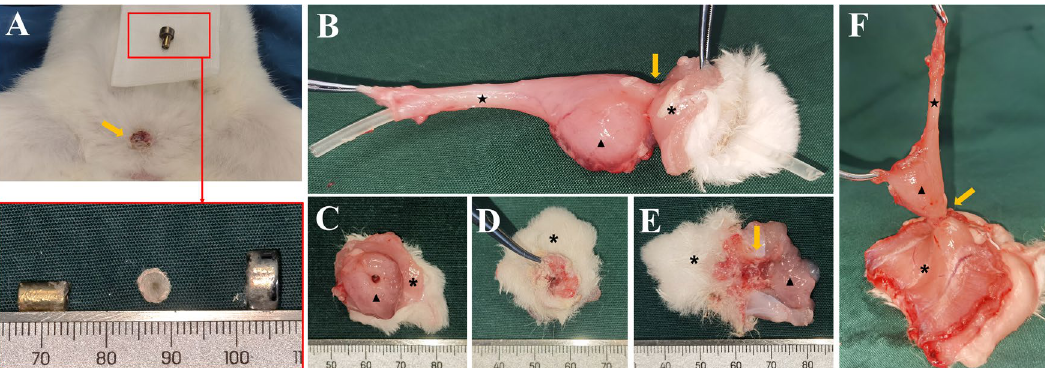
Figure 5. Gross specimens of bladder fistula. ( A ) Photograph showing the bladder fistula on the abdominal wall and the fallen-off magnets [the lower panel shows the daughter magnet (left), necrotic tissue (middle), and parent magnet (right)]. ( B ) The fistula specimen is unobstructed enough to allow the passage of the tube through it. ( C ) Fistula on the side of the bladder. ( D ) Fistula on the side of abdominal wall. ( E ) Longitudinal section through the fistula. ( F ) The bladder fistula is closely adhered to the abdominal wall, but there are no adhesions elsewhere (“ ★ ” is the urethra; “ ▲ ” is the bladder; “*” is the abdominal wall; the orange arrow indicates the fistula).